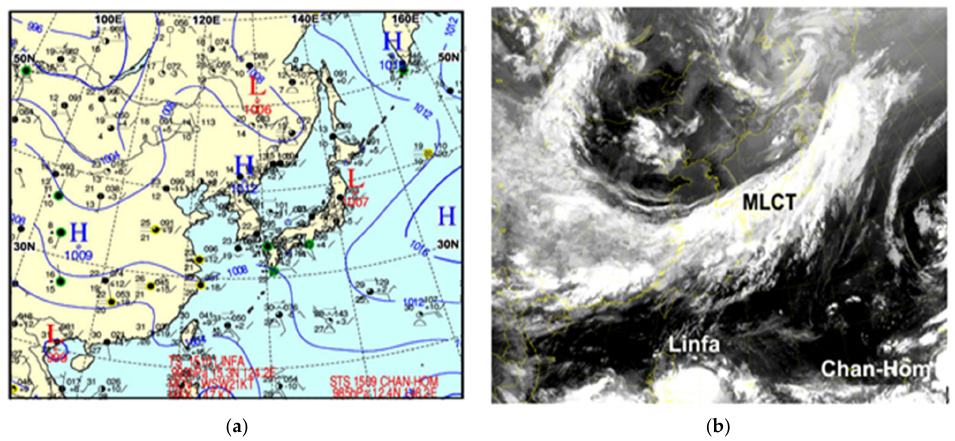
Figure 3. ( a ) Surface pressure chart and ( b ) COMS ‐ IR satellite image at 09:00 LST, 4 July 2015. Small black circles of observation points in ( a ) denote clouds and precipitation. The MLCT indicates a mid ‐ latitude cloud band ‐ associated trough between a low pressure in the north and the North Pacific Ocean High Pressure (H on the right edge of ( a )) between the latitudes of 20°N and 40°N.